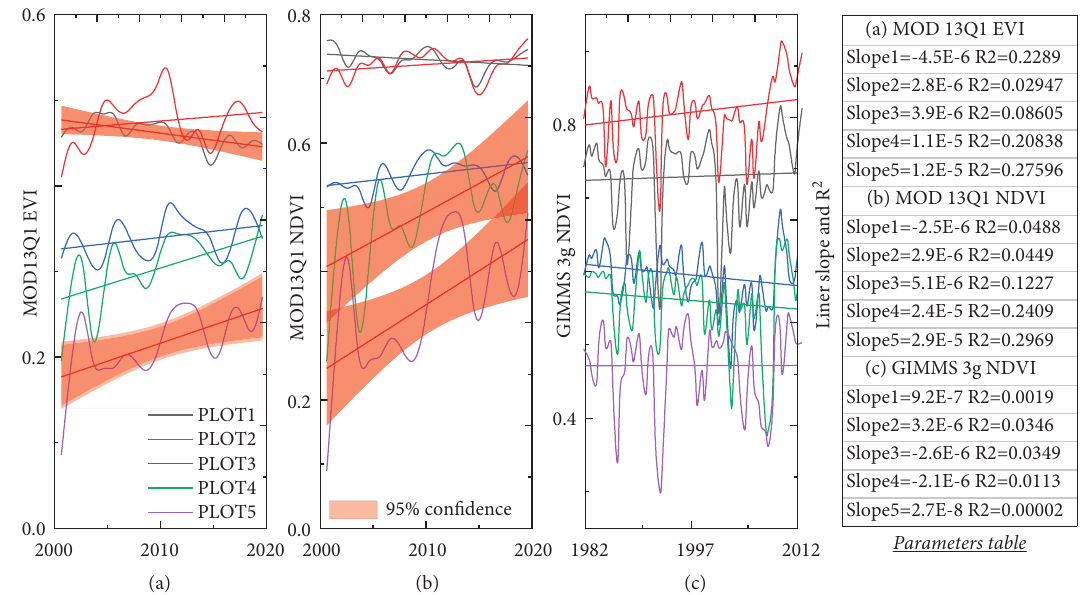
Figure 5: Vegetation change trend of the swamp wetland on a plot-scale. (a), (b), and (c) are the change trend of MOD13Q1 EVI